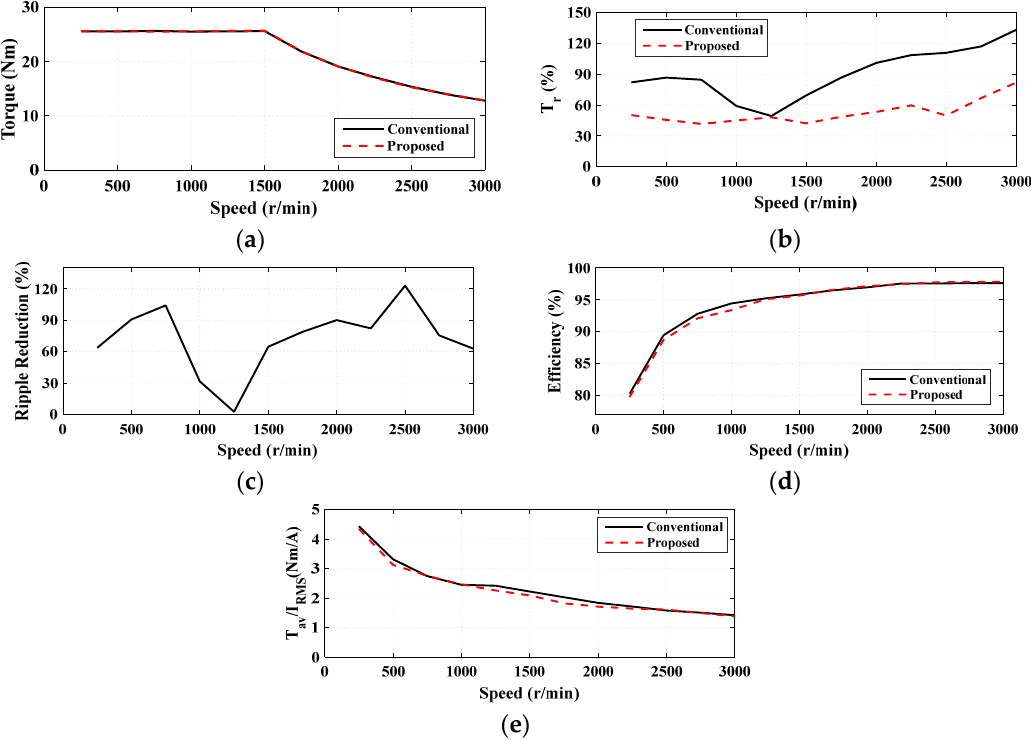
Figure 8. The steady-state performance curves: ( a ) average torque; ( b ) torque ripple; ( c ) percentage of torque ripple reduction; ( d ) efficiency; ( e ) torque/current ratio.